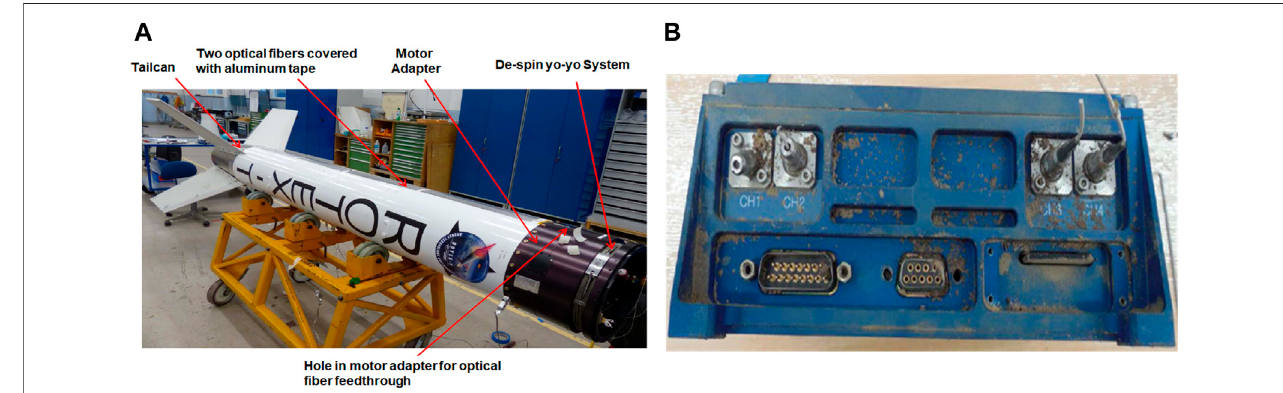
FIGURE 16 | (A) Fiber Sensor lines integrated within ROTEX-T structure, (B) Interrogator front with the connectors, three of them having their fi bers still